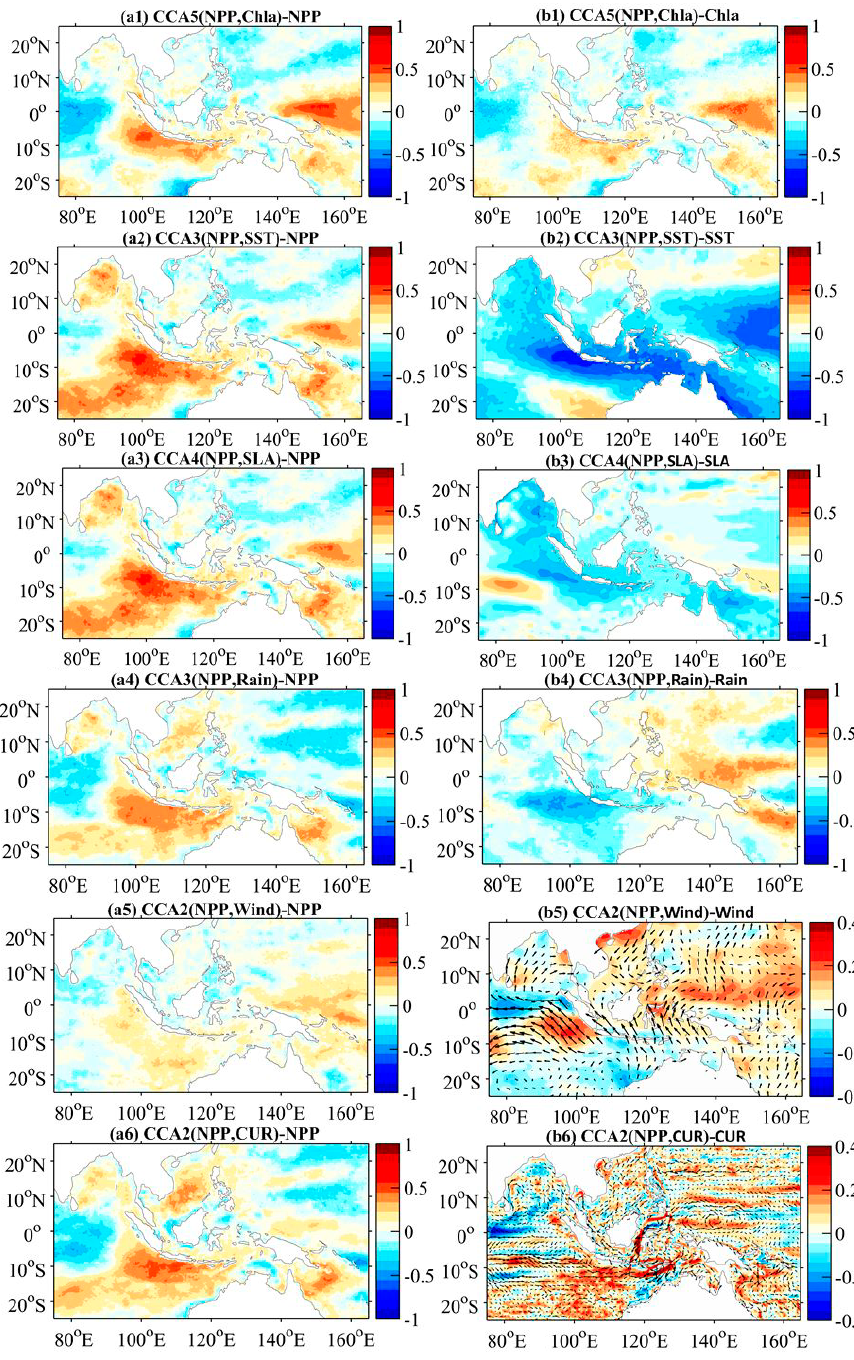
Figure 10. Same as Figure 9, but for the canonical coupled CCA modes associated with IOD. ( a1 , b1 ) spatial correlation patterns of NPP and Chla for the fifth canonical pair labeled as CCA5 (NPP, Chla)-NPP and CCA5 (NPP, Chla)-Chla, respectively. ( a2 – a6 , b2 – b6 ) are similar as ( a1 , b1 ) but for the modes of NPP with SST, SLA, Rain, Wind, and CUR, respectively.